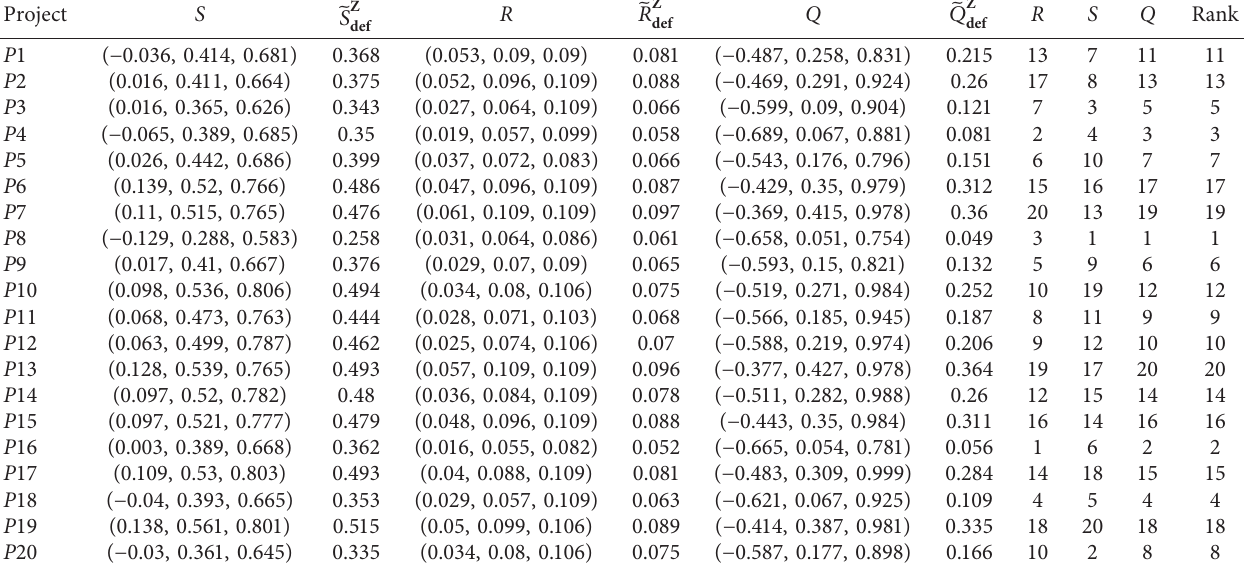
Table 49: Project ranking table (20